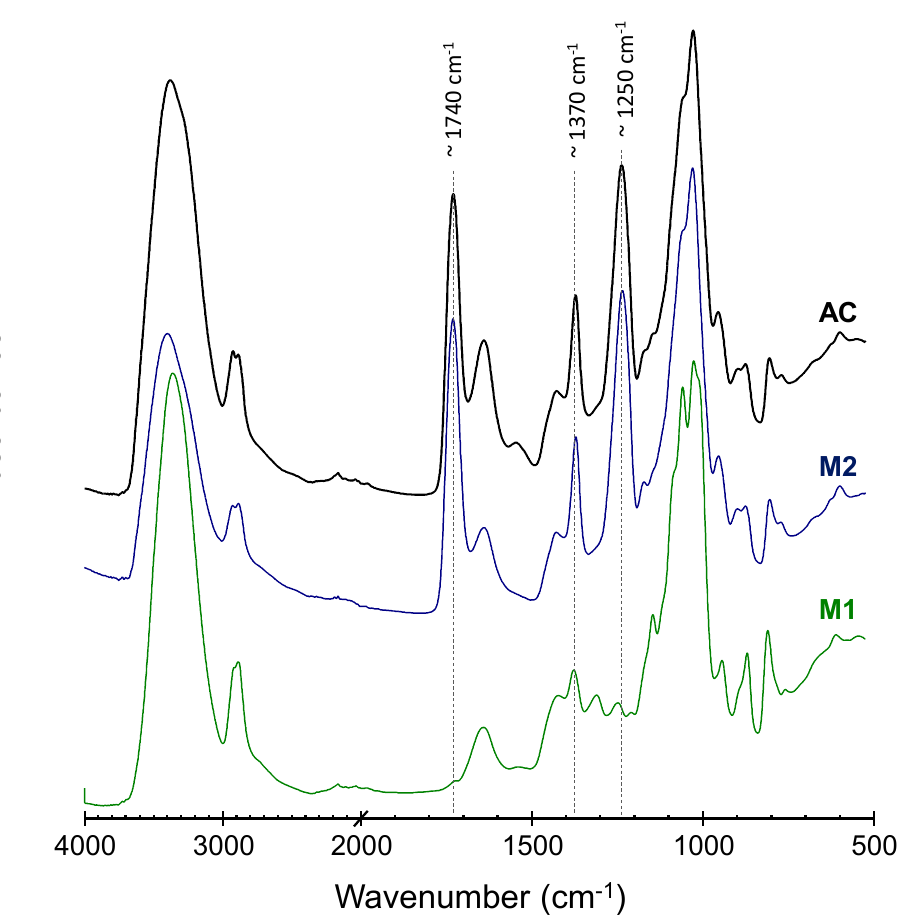
Figure 5. ATR-FTIR spectra of acemannan (AC), M1 and M2 aerogels.